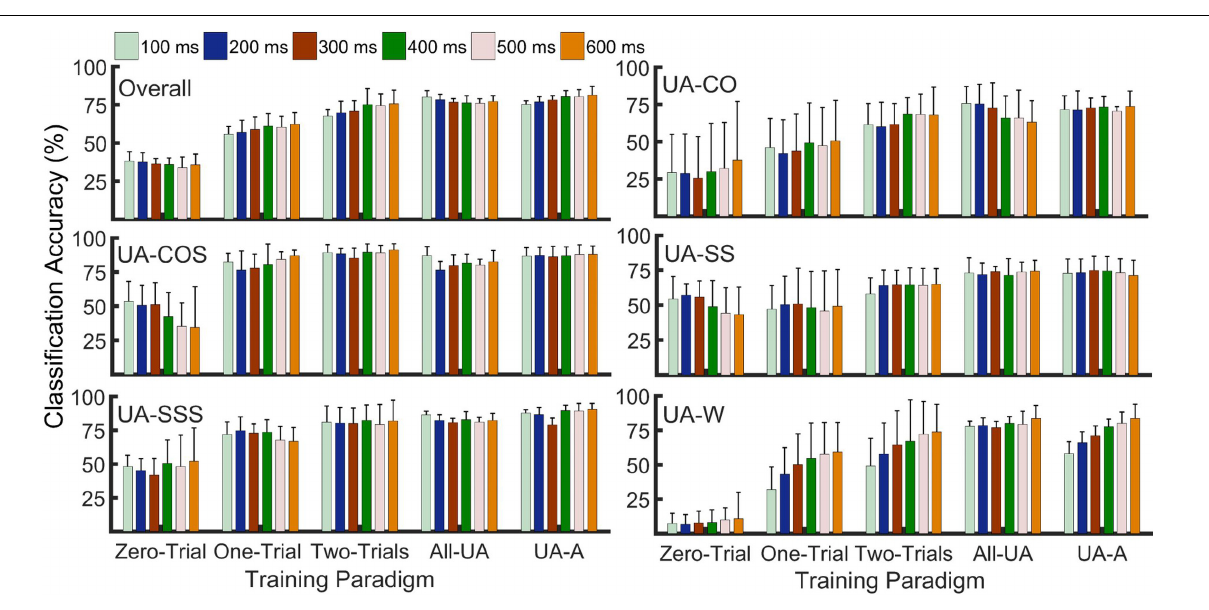
FIGURE 4 | Effects of varying analysis window lengths and training paradigms on recognition accuracy of unanticipated straight walking (UA-W), cuts (UA-SS, UA-CO), and cut to stair ascent (UA-COS, UA-SSS). Zero-Trial provided the lowest accuracy in all locomotor tasks. Including a few bouts of target task significantly improved the accuracy. However, there was no statistically significant difference between Two-Trials, All-UA, and UA-A training paradigms ( α = 0.01). Altering analysis window size did not result in a significant change in task recognition